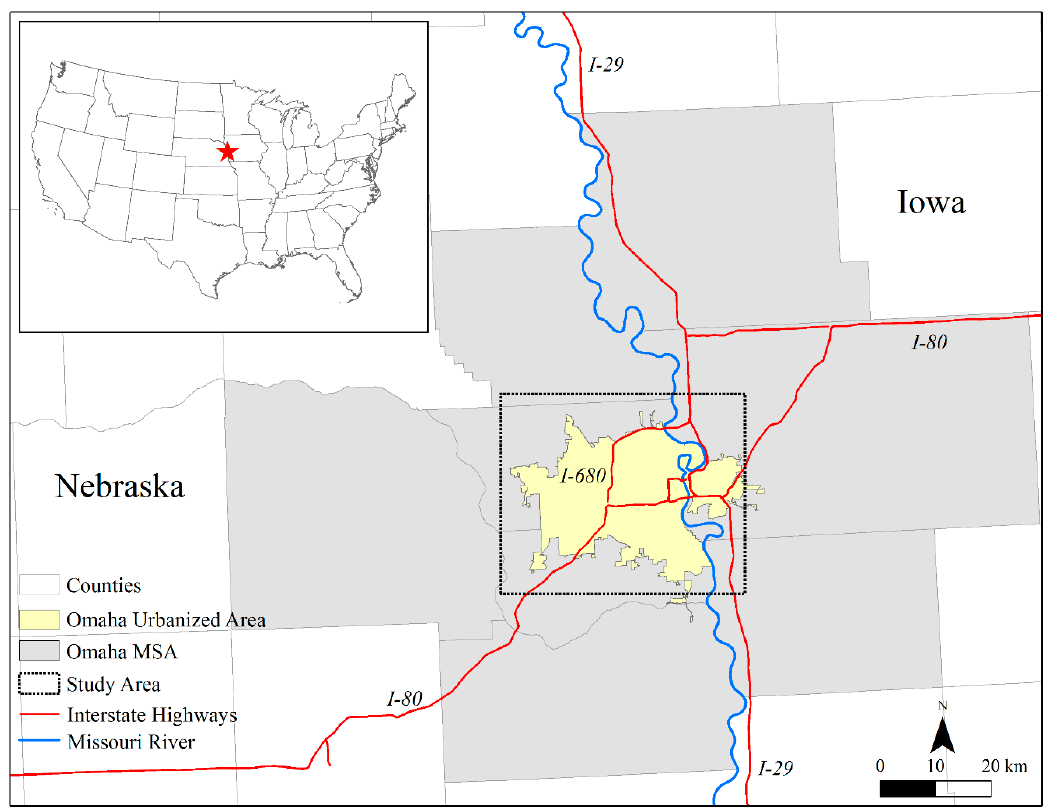
Figure 1. The Omaha study area and surrounding region.